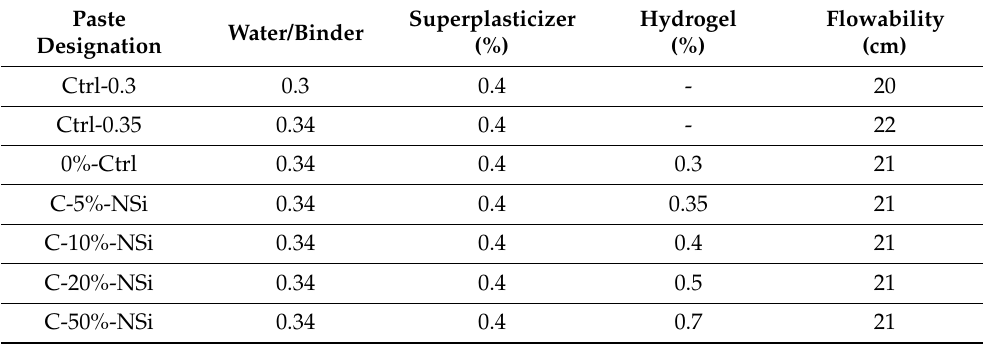
Table 2. Mix design and flowability of cement pastes hydrogels containing nano-silica particles for internal curing